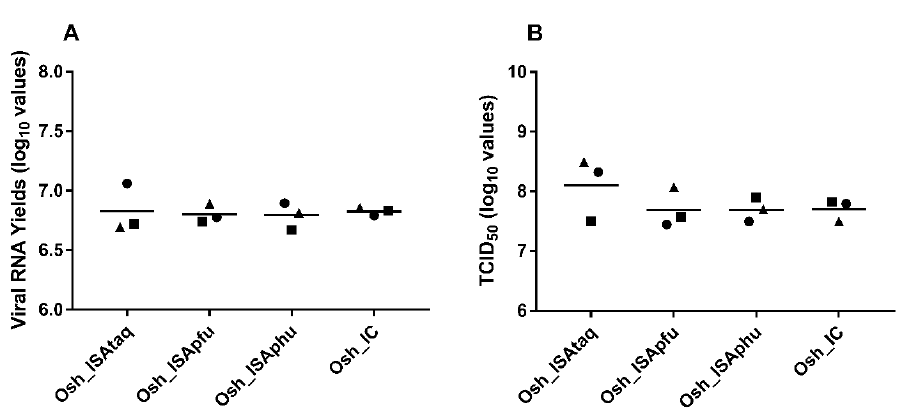
Figure 3. Viral replicative fitness. Viral loads in cell supernatant media of each replicate were estimated using a real-time RT-PCR assay (molecular viral loads) ( A ) and a Tissue Culture Infectious Dose 50 (TCID 50 ) assay (infectious titers) ( B ). Circles, squares, and triangles correspond to the first, second, and third replicates, respectively, and dashes represent mean values.